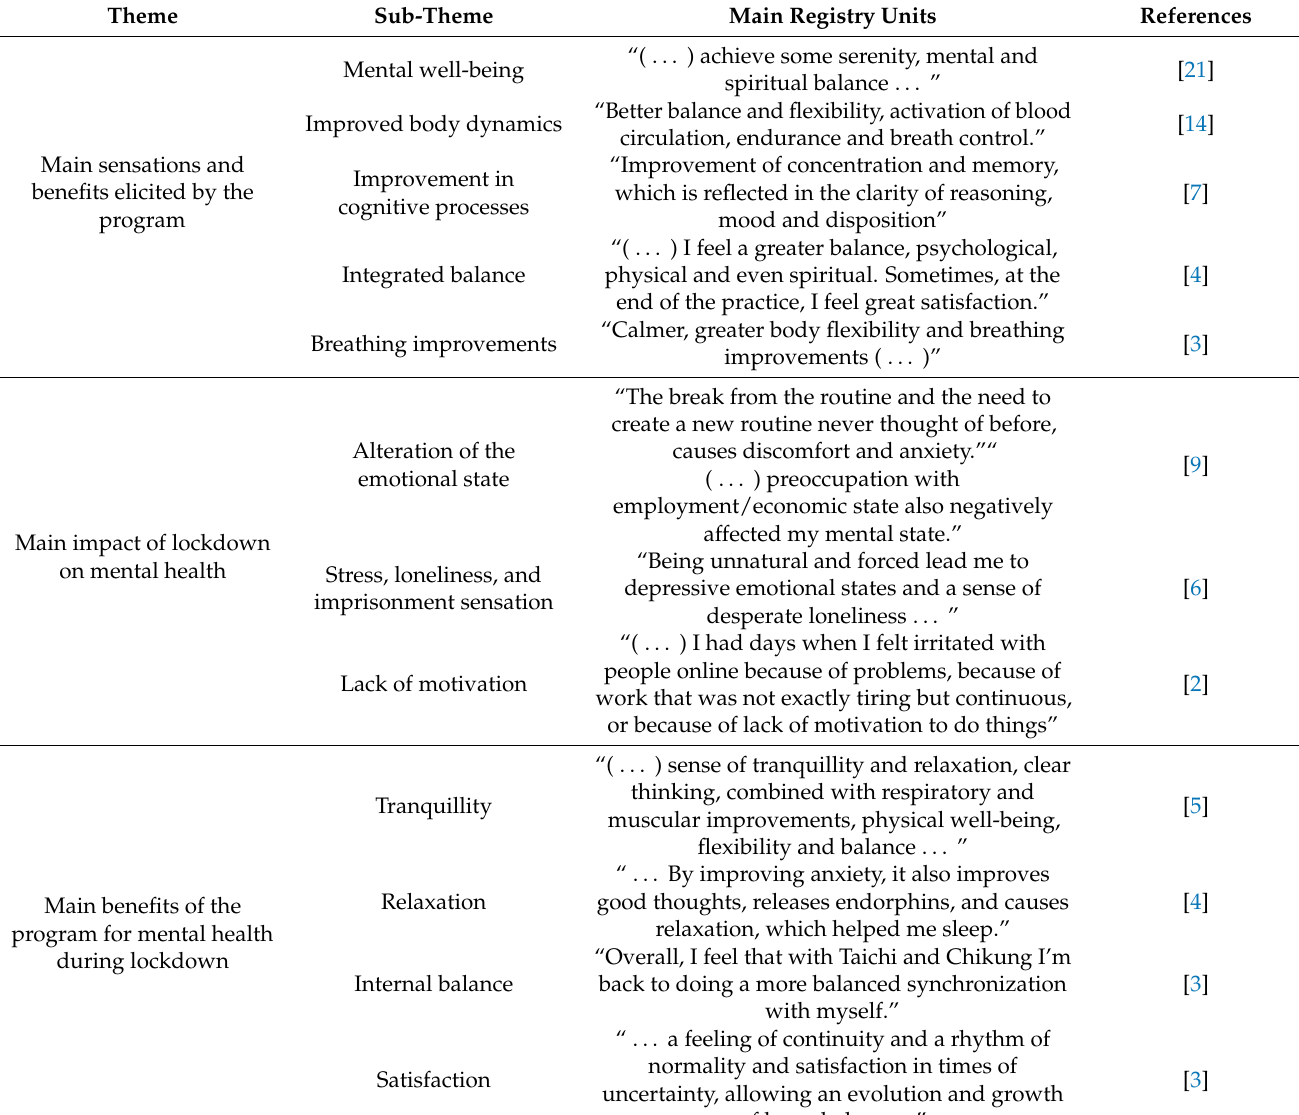
Table 3. Themes, sub-themes and main registry units retrieved from the qualitative analysis of the